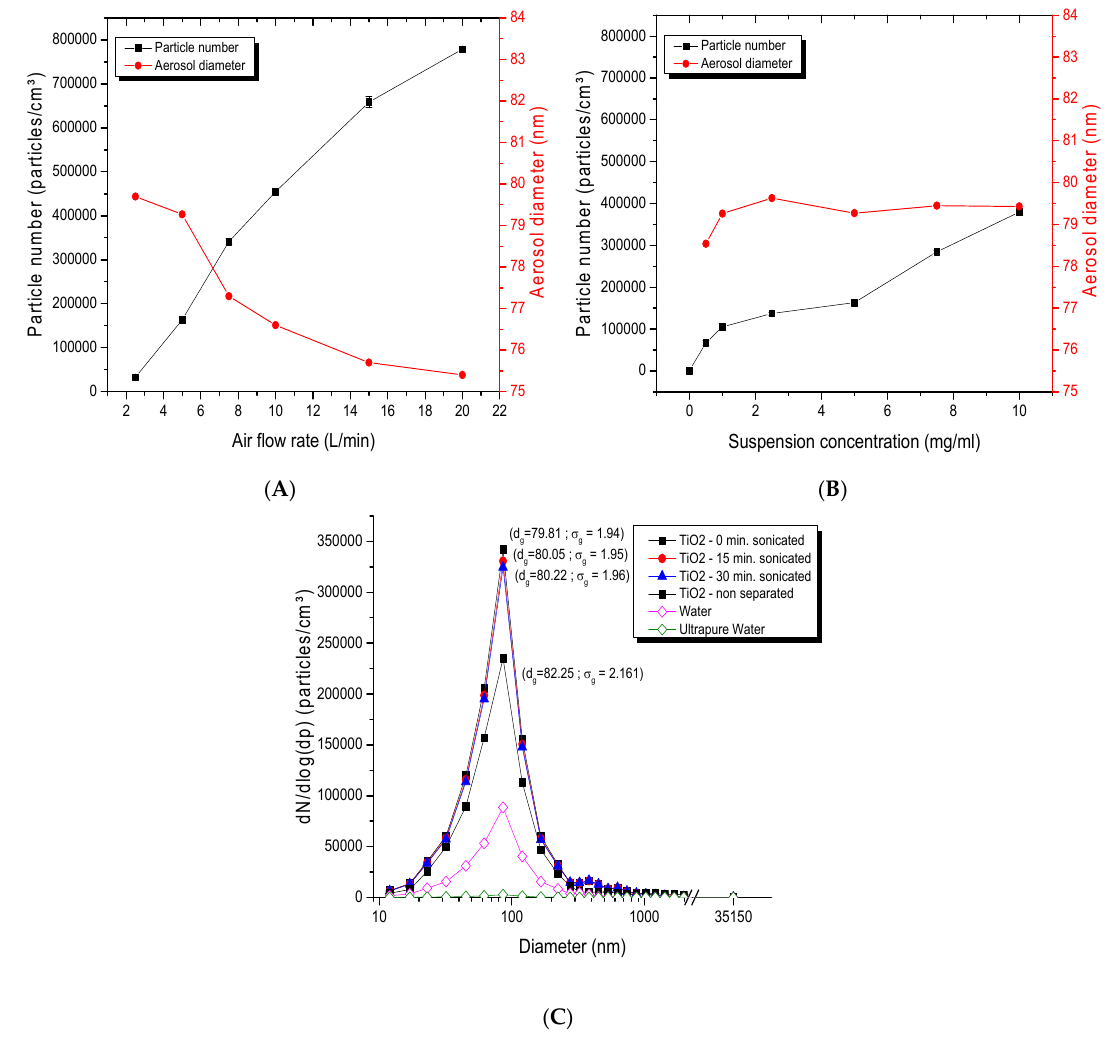
Figure 5. Parameters influencing collision ‐ jet aerosol generation: average diameter and number of particles of TiO 2 in the aerosols as function of: ( A ) airflow rate; ( B ) nanoparticle (NP) suspension concentration (with TiO 2 (20 nm) suspension concentration in ( A ) and airflow rate in ( B ) at 5 mg/L and 5 L/min, respectively); ( C ) size distribution of TiO 2 sonicated for different durations, use of deionized water compared to tap water, and effects of use of a laminar airflow separator (a suspension of 20 nm TiO 2 NPs at 5 mg/mL, and ultrapure and unpurified water were used at an airflow rate of 5 L/min). For the dust-jet generator, as shown in Figure 6A, the number of particles increased with increasing airflow rates, while the particle diameter decreased. For an airflow rate of 0.8 L/min, the geometric mean diameter was 86.93 nm with a σ g of 2.31. This diameter slightly decreased to 80.77 nm with